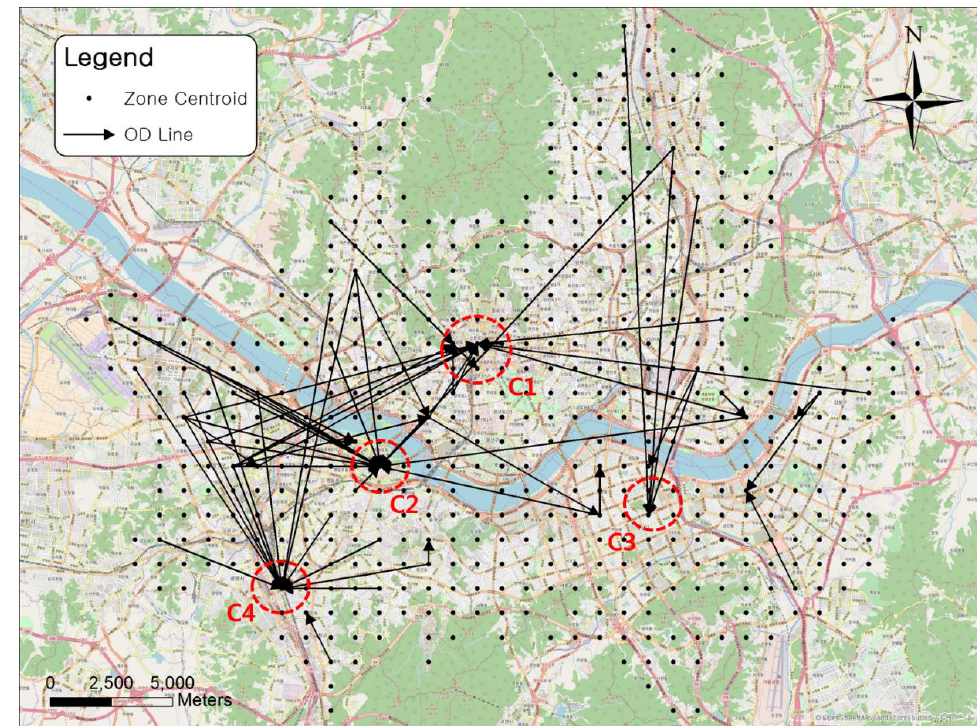
Figure 6. [AM peak] Service disparity